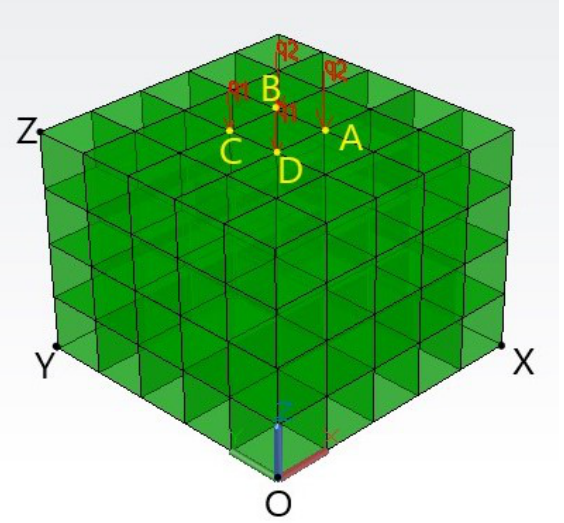
Figure 3. Geometry of the finite element mesh. The dimensions are OX = 5 m, OY = 5 m, YZ = 4 m, and for the equivalent forces, it holds that q 2 ≥ q 1 . The finite element mesh consists of hexahedral finite elements with linear shape